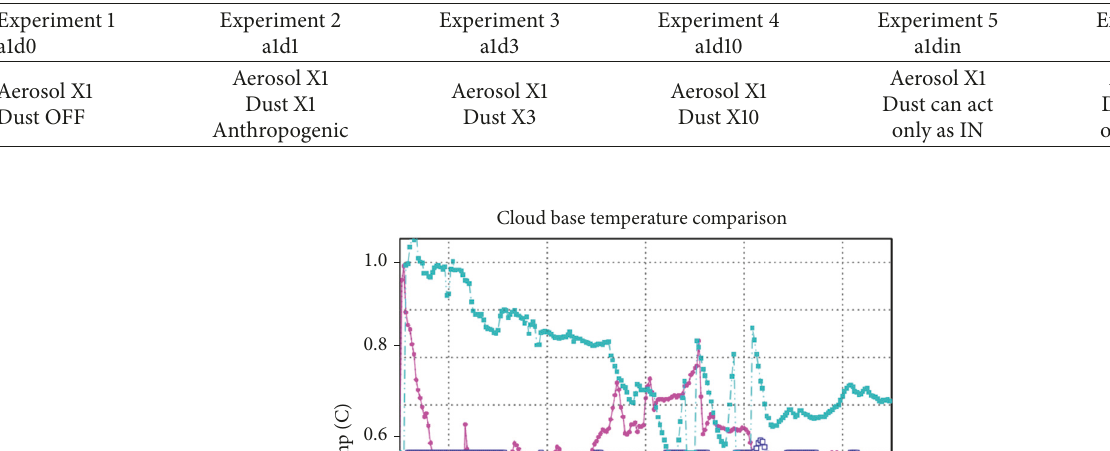
Table 2: Sensitivity tests types.